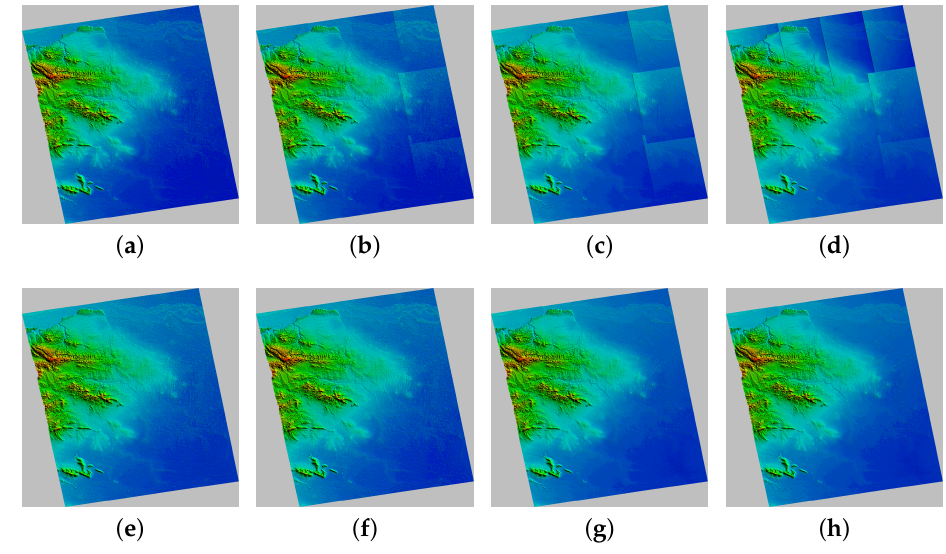
Figure 13. The geocoded map of generated DEMs after adjustment: ( a – d ) are adjusted using the conventional method, while ( e – h ) are adjusted using the proposed method.